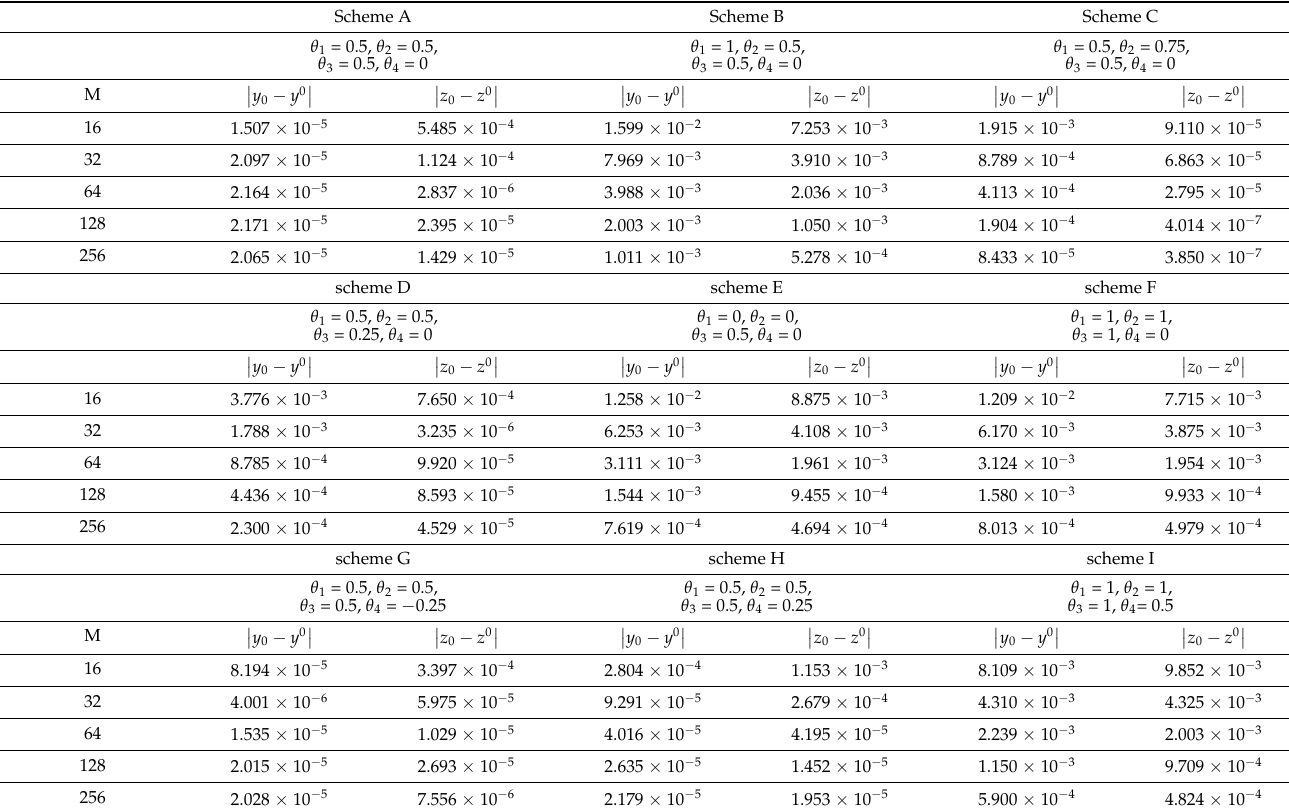
scheme G scheme H scheme